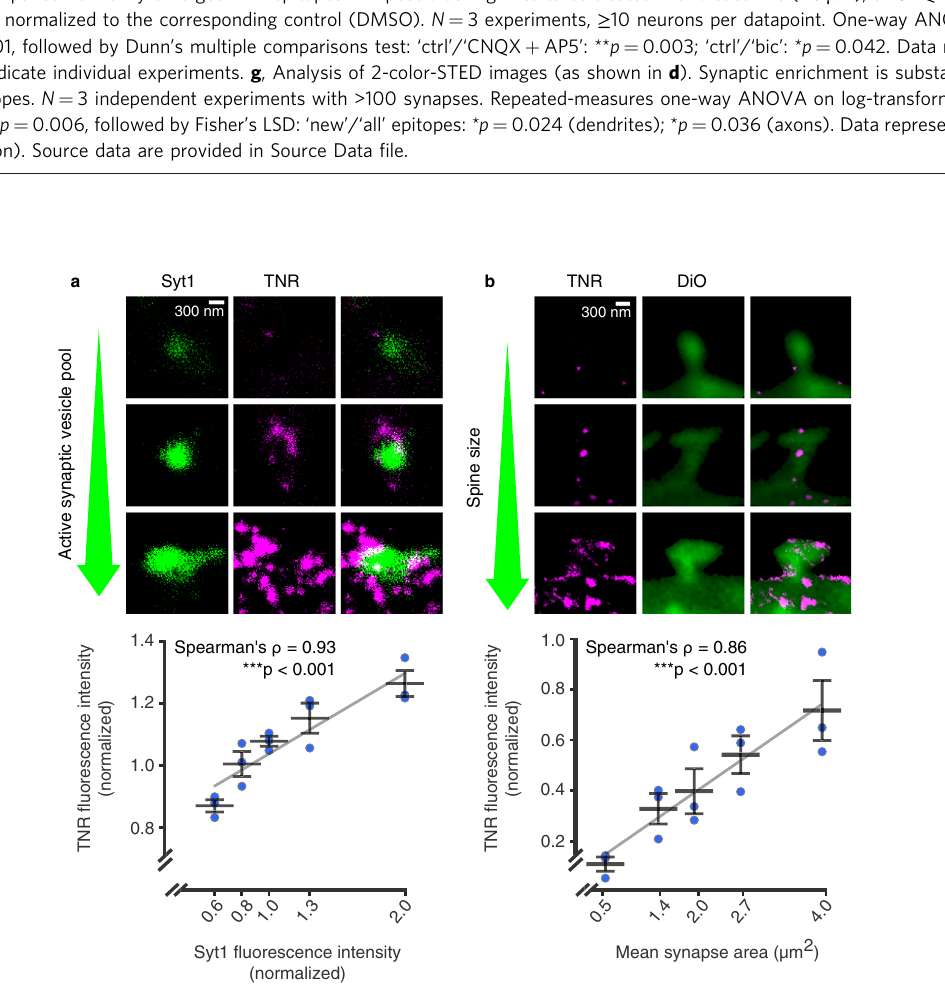
Fig. 3 The emergence of TNR epitopes is dependent on synaptic weight. a The TNR epitopes in the ECM were blocked as in the previous experiments, and 12 h later the cultures were incubated with fl uorophore-conjugated TNR antibodies (magenta) and with fl uorophore-conjugated antibodies for the intra-vesicular domain of Syt1 (green), which reveal the synaptic vesicle pool that undergoes exo- and endocytosis (the active pool). The size of this pool is a measure of the activity of the respective boutons. The panels show example synapses with different active vesicle pools, imaged in STED (TNR) and confocal (Syt1). Scale bar = 300 nm. The graph shows the mean fl uorescence intensities normalized to the median intensity of the respective experiment. The Syt1 intensities are binned to include an equal number of synapse images. An analysis of the correlation of the TNR signal at Syt1-labeled synapses indicates that the TNR signals correlate strongly with the size of the active vesicle pool in the respective boutons. N = 3 independent experiments, with >1100 synapses per datapoint, Spearman ’ s ⍴ = 0.927, ** *p = 6.489 × 10 − 7 (two-sided). b Newly-emerged TNR epitopes (magenta) were labeled after 12 h as in panel a, and the neuronal plasma membrane was visualized with DiO (green). The panels show example spines with different sizes, imaged in STED (TNR) and confocal (DiO). Scale bar = 300 nm. The graph shows the mean fl uorescence intensity of TNR and the mean synapse area, normalized to the median values in the respective experiment. The synapse area values are binned to include an equal number of synapse images. An analysis of the correlation of the TNR signal at DiO-labeled spines indicates that the TNR signals correlate strongly with the size of the dendritic spine for newly-emerged TNR epitopes. N = 3 independent experiments, with >280 synapses per datapoint, Spearman ’ s ⍴ = 0.862, ** *p = 3.601 × 10 − 5 (two-sided). All data represent the mean ± SEM, with dots indicating individual experiments. Source data are provided in Source Data fi